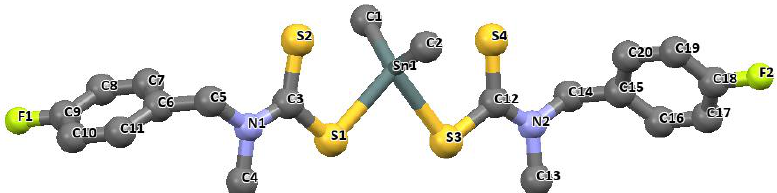
Figure 7. The molecular structure of dimethyltin(IV) bis( p -fluoro- N -methylbenzylamine dithiocarbamate). (For clarity, H atoms were omitted) [83]. Redrawn from [83], with permission from Elsevier (Copyright 2018).